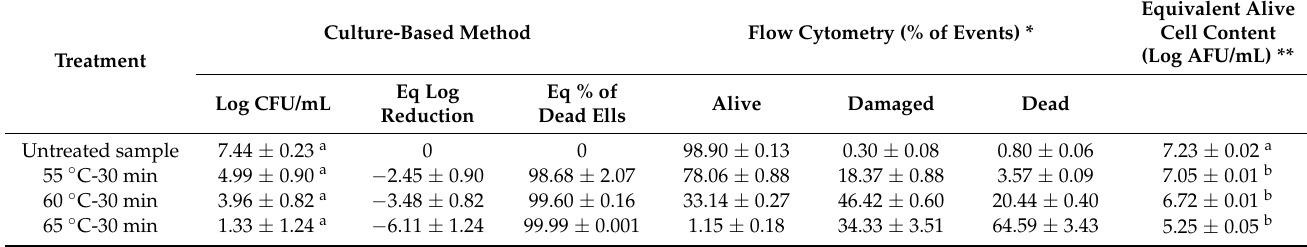
Table 1. Estimation of E. coli ATCC 25922 growth by using culture-based method (Log CFU/mL) and population distribution by FCM analysis (Log AFU/mL).